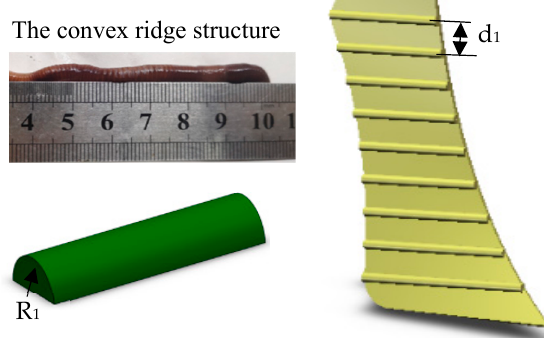
Figure 2. The semicircular corrugated structure of the shovel chest.